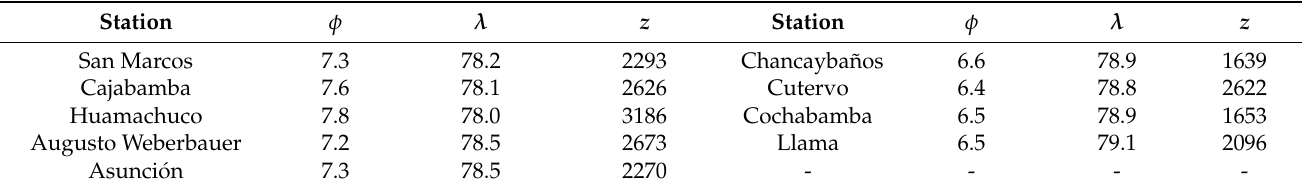
Table 1. Weather stations, with latitude ( φ , ◦ S), longitude ( λ , ◦ W), and altitude ( z , masl) for 25-year historical